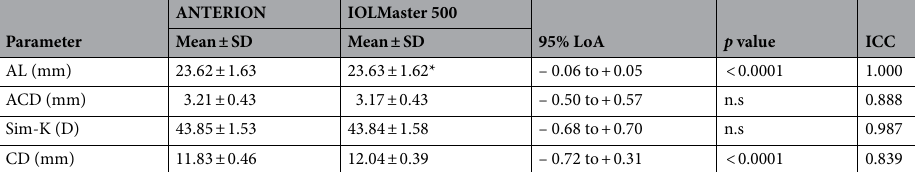
Table 4. Comparison between the mean values measured by the ANTERION and IOLMaster 500. SD standard deviation, LoA limits of agreement, ICC Intraclass correlation coefficient (between ANTERION and IOLMaster 500), AL axial length, ACD anterior chamber depth, Sim-K simulated keratometry, CD corneal